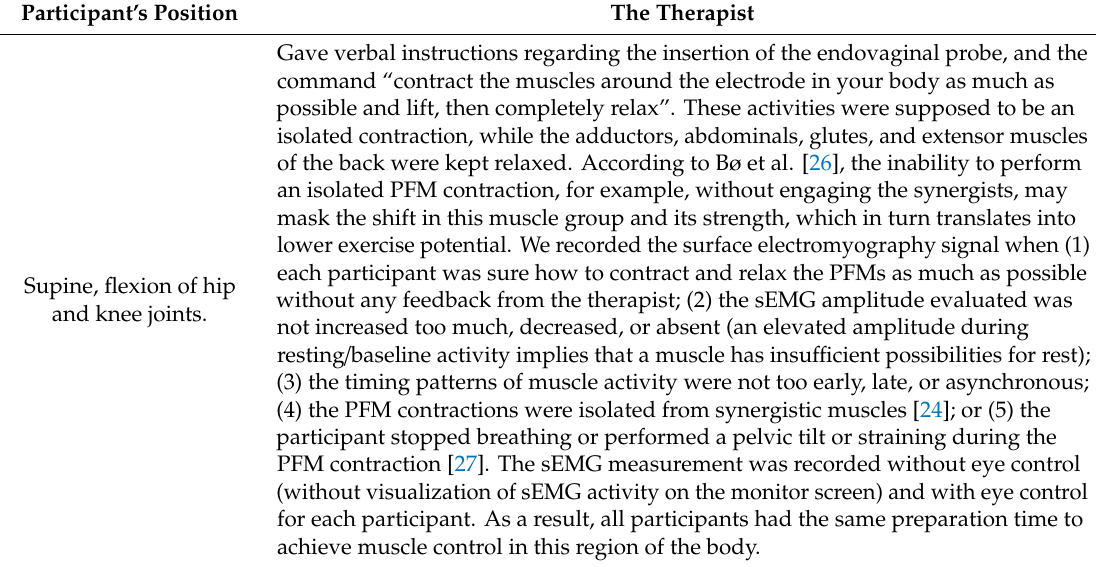
Table 2. Pelvic floor muscle (PFM) contraction and relaxation